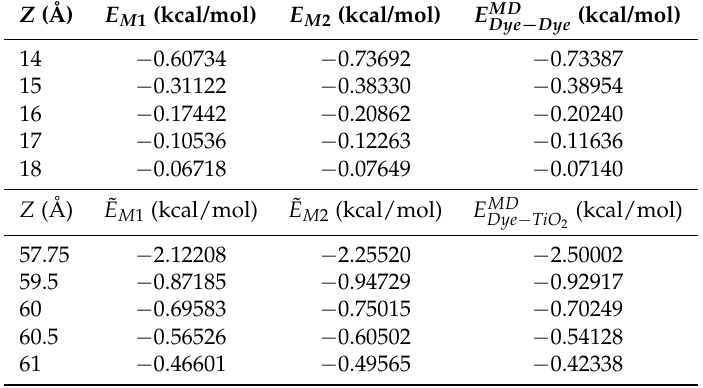
Figure 7. Interaction energy between ( a ) two dye molecules and ( b ) dye molecule interacting with TiO 2 molecule obtained from continuum Models I and II, and from MD simulation. Table 1. Energies for dye-dye and dye-TiO 2 interactions of Model I ( E M 1 ), Model II ( E M 2 ), and MD ( E MD